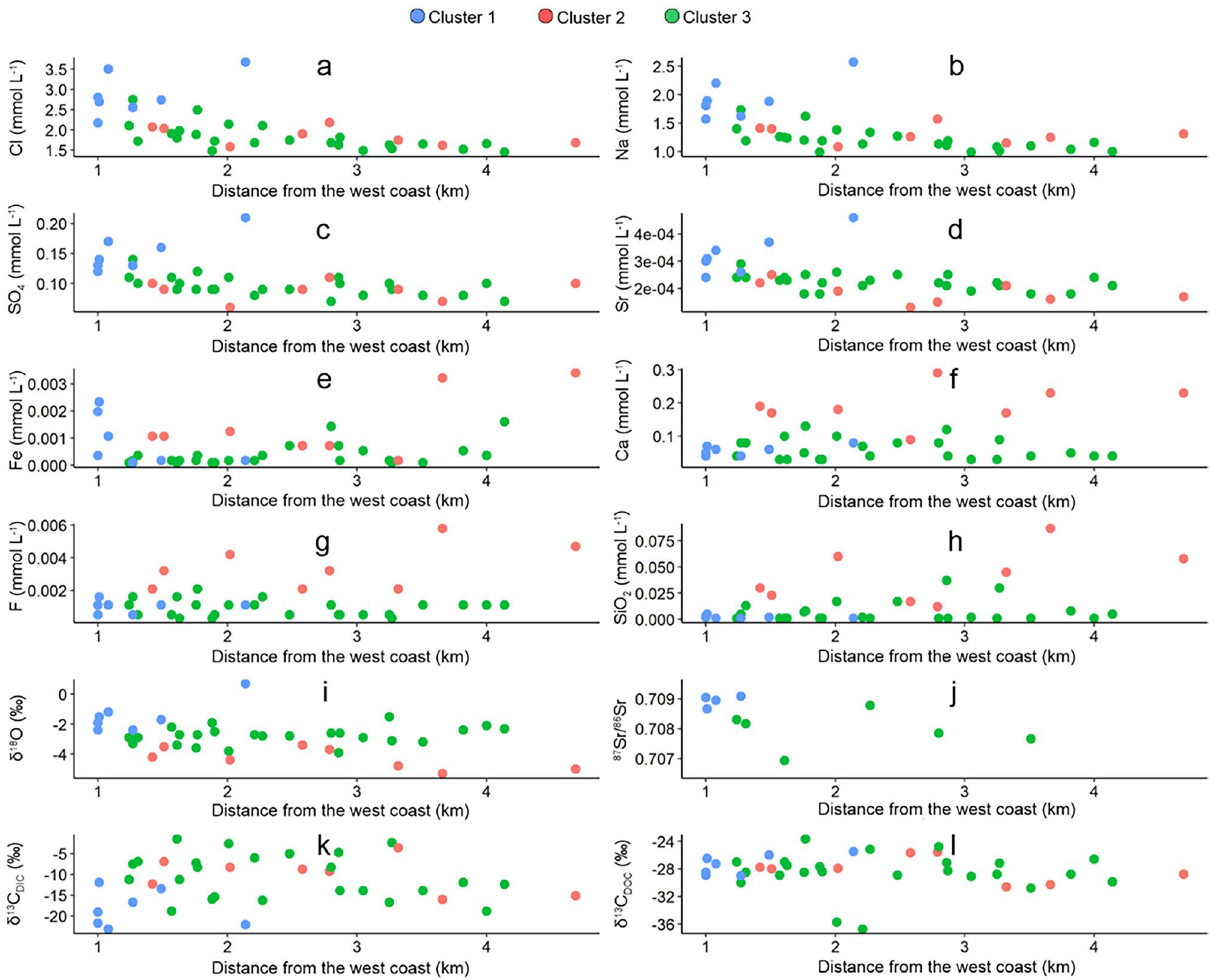
Figure 5. Distribution of ion concentrations and isotopes relative to distance from the west coast. Note the generally high concentrations of ( a ) Cl, ( b ) Na, ( c ) SO 4 and ( d ) Sr in the lakes from Cluster 1 (green) are located close to the west coast. Concentrations of ( e ) Fe are mixed in lake waters impacted by sea-spray, whilst concentrations of ( f ) Ca, ( g ) F and ( h ) SiO 2 are low in these lakes and increase with distance from the west coast, particularly in samples identified as having undergone high water–rock interaction. Lakes in Cluster 1 located close to the west coast contain higher ( i ) δ 18 O and ( j ) 87 Sr/ 86 Sr ratios and relatively low ( k ) δ 13 C DIC values. δ 13 C DOC values ( l ) show no significant relationship with distance from the west coast ( p > fall source that may be from direct precipitation into the lake catchment or by rainfall that has been recharged as groundwater into the underlying bedrock aquifer. The lakes can be broadly grouped into three clusters based on hydrochemistry and isotopic compositions (Fig. 6). Cluster 1 is associated with lakes on the western side of the island and while dilute in concentration compared to seawater, they contain higher concentrations of Na, Cl, Mg, K and SO 4 , ions which are found in seawater 38,39 . The highest concentrations of these ions occur along the west coast (LK3, 6, 10, 18, 37, 38, 44) and decrease in concentration with increasing distance from the west coast (Fig. 7). Within Cluster 1, four samples (LK6, 37, 38, 44) were analysed for 87 Sr/ 86 Sr isotope ratios (0.70866, 0.70894, 0.70908, 0.70904, respectively) and were close to